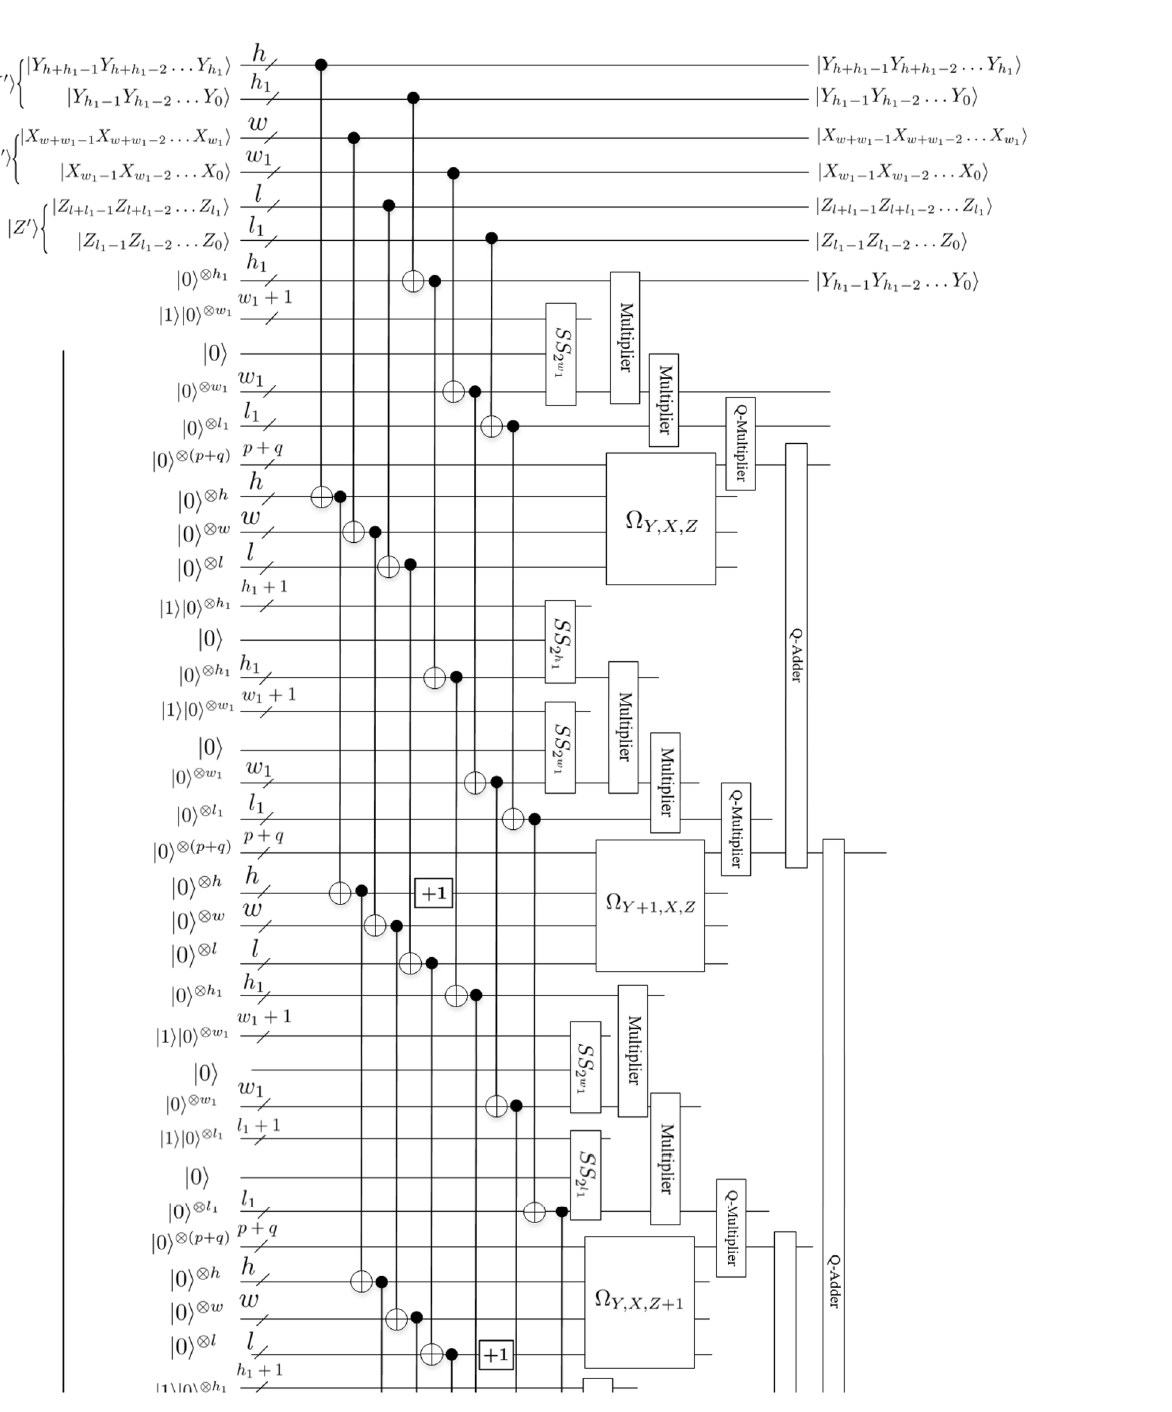
Figure 17. Scaling-up